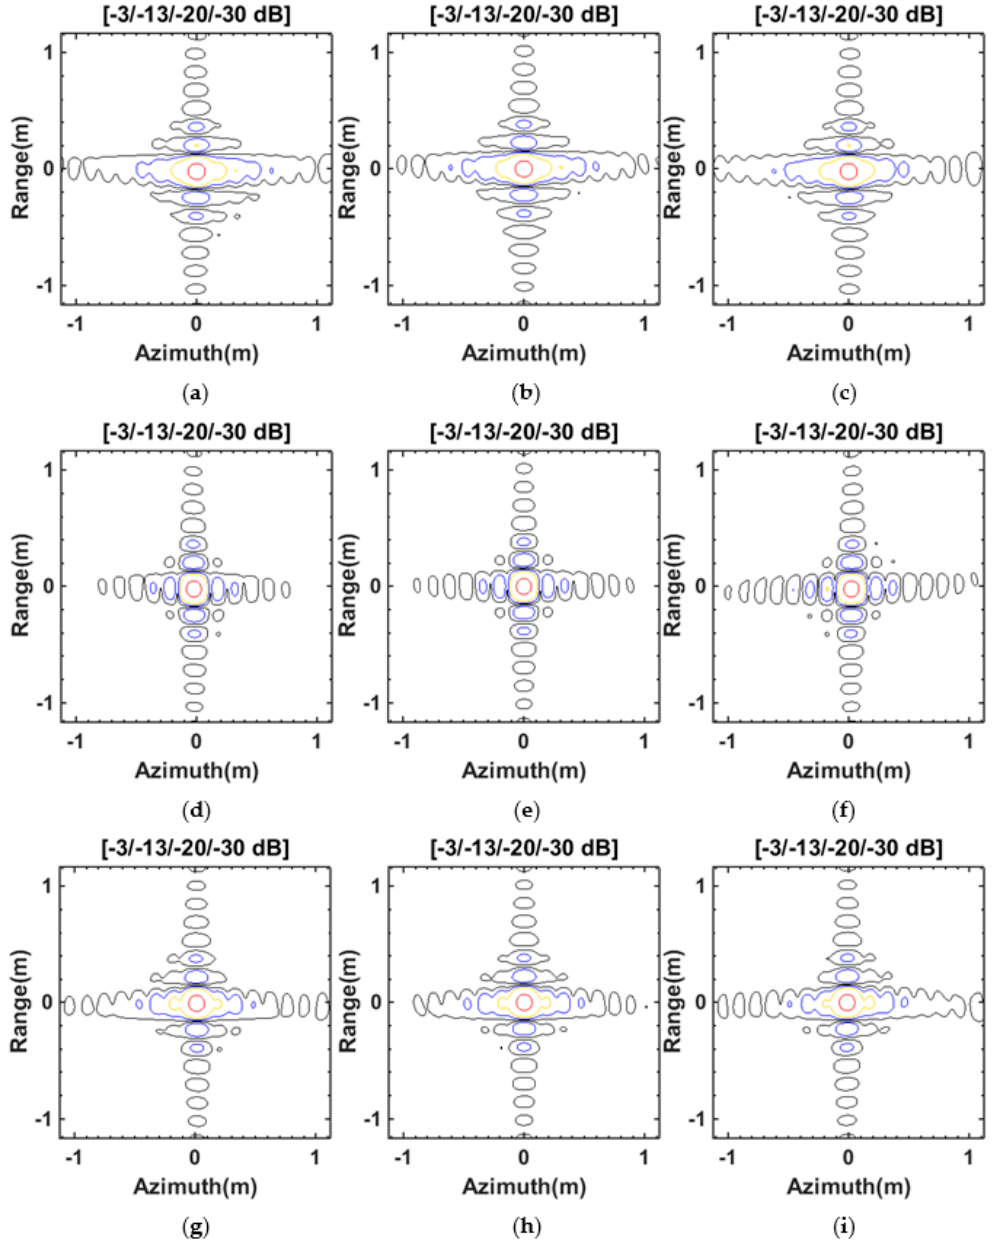
Figure 9. Imaging results with the generalized ω K ( a ) Imaging result of target T 1 ; ( b ) Imaging result of target T 2 ; ( c ) Imaging result of target T 3 ; ( d ) Imaging result of target T 4 ; ( e ) Imaging result of target T 5 ; ( f ) Imaging result of target T 6 ; ( g ) Imaging result of target T 7 ; ( h ) Imaging result of target T 8 ; ( i ) Imaging result of target T 9 .